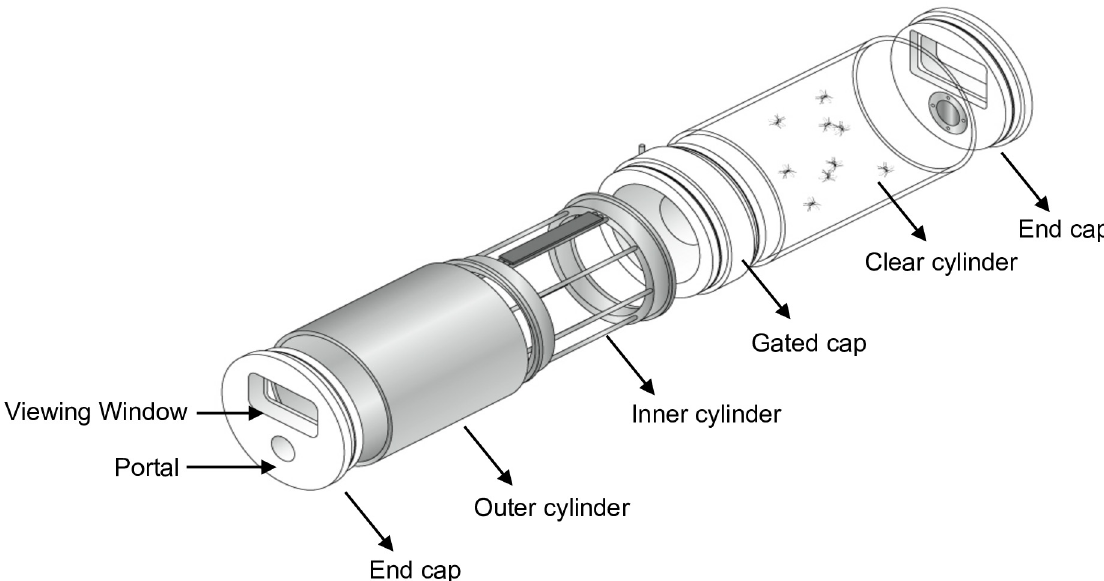
Fig 2. High-Throughput Screening System (HITSS). The HITSS chambers are modular, consisting of metal cylinders attached to clear cylinders. Treated netting is placed inside the metal cylinder and mosquitoes introduced into the clear chamber to prevent making direct contact with the chemical but allowing for chemical exposure (by permission of the American Mosquito Control Association) [25].